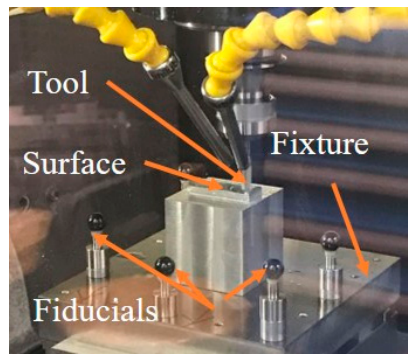
Figure 6. Machining surface by a machine tool.